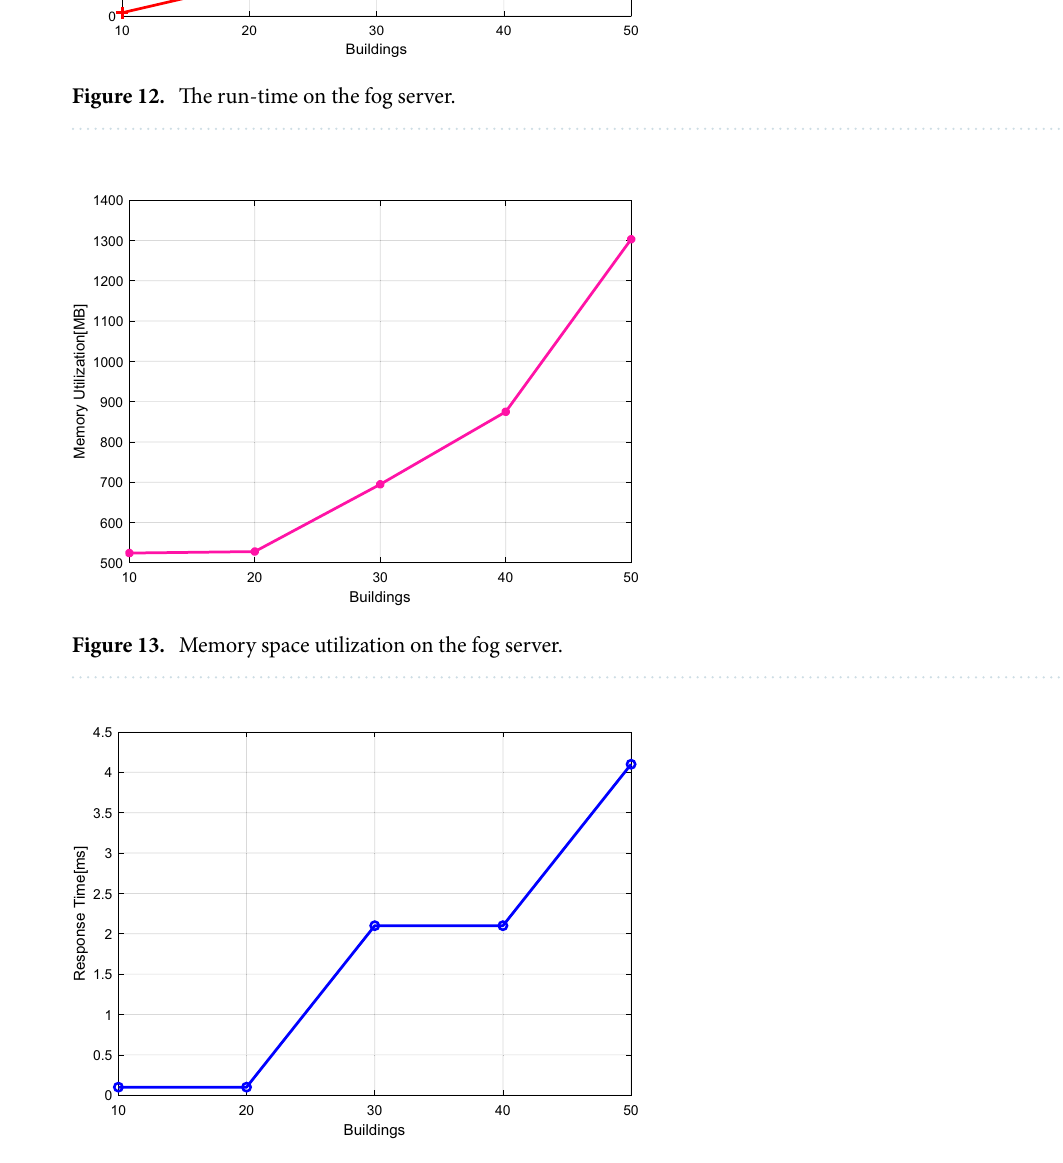
Figure 14. The data’s estimation of the network response delay